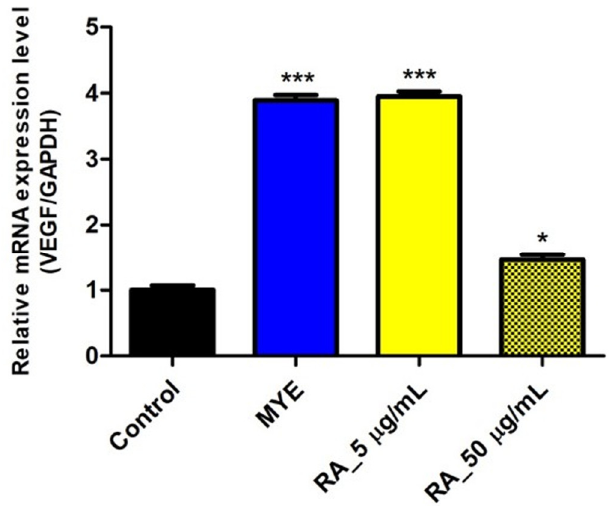
Figure 7. Effect of rosmarinic acid on VEGF mRNA expressions in HFDPC. Relative mRNA levels of VEGF were monitored by qPCR and normalized against GAPDH. Data are presented as mean ± SE. Significant differences are indicated by * p < 0.05 and *** p < 0.001, relative to the control group. SE, standard error; VEGF, vascular endothelial growth factor; MYE, medicinal yeast extract; RA, rosmarinic acid.